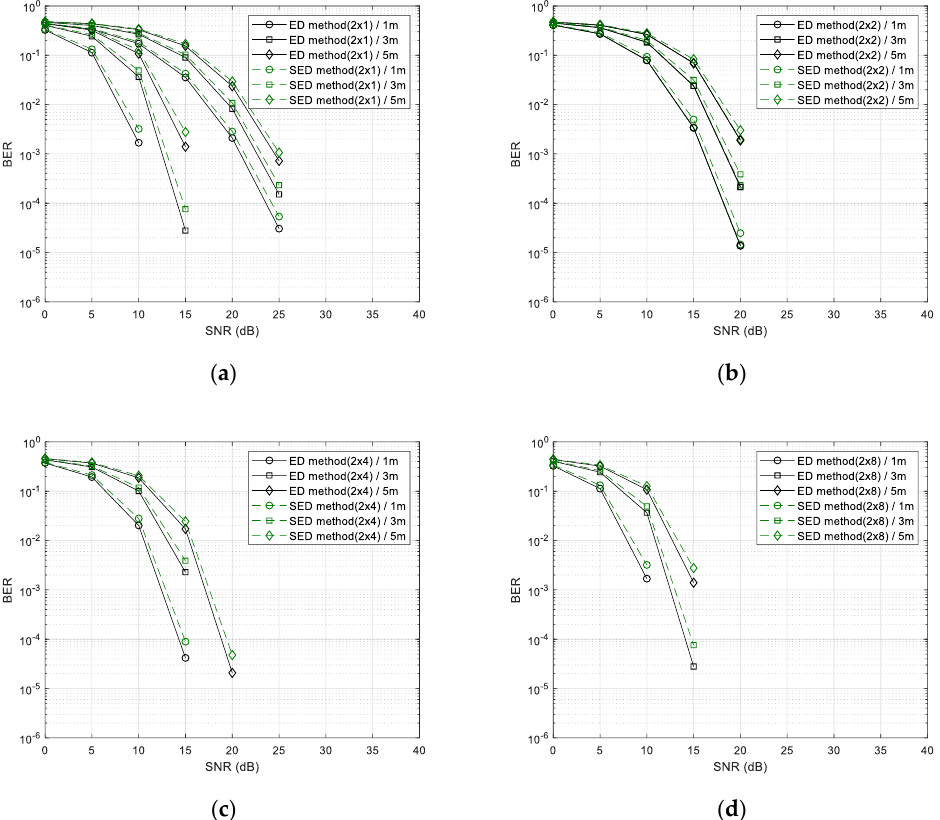
Figure 11. BER performance of SED method for the number of received (Rx) antennas (1, 2, 4, and 8). ( a ) The number of Rx antennas is 1; ( b ) the number of Rx antennas is 2; ( c ) the number of Rx antennas is 4 and ( d ) the number of Rx antennas is 8.